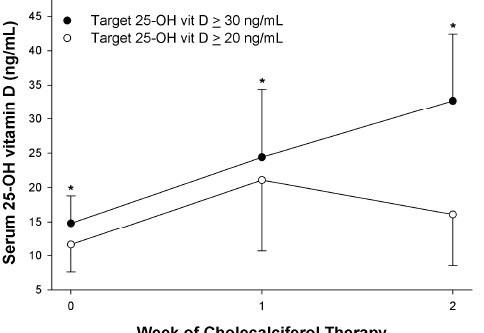
Figure 1. Serum 25-hydroxy vitamin D response to cholecalciferol therapy between the lower target (25-OH vit D ≥ 20 ng/mL) and higher target (25-OH vit D ≥ 30 ng/mL) groups, respectively. Week 2 concentrations were from 21 and 29 patients from the lower and higher 25-OH vit D target groups, respectively. Data given as mean + S.D. * p < 0.05 between target groups by week of therapy.